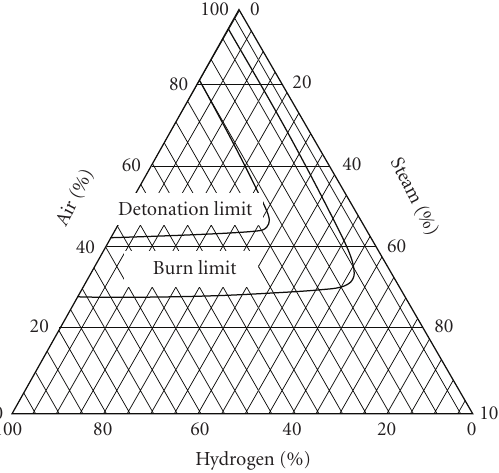
Figure 1: Shapiro diagram for hydrogen-air-steam